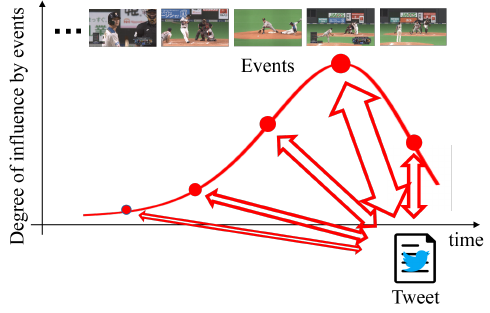
Figure 2. Relationship between multiple events and a tweet affected by them. Additionally, these events were weighted by the degree of influence defined using the Poisson distribution. This figure is an adaptation from Reference